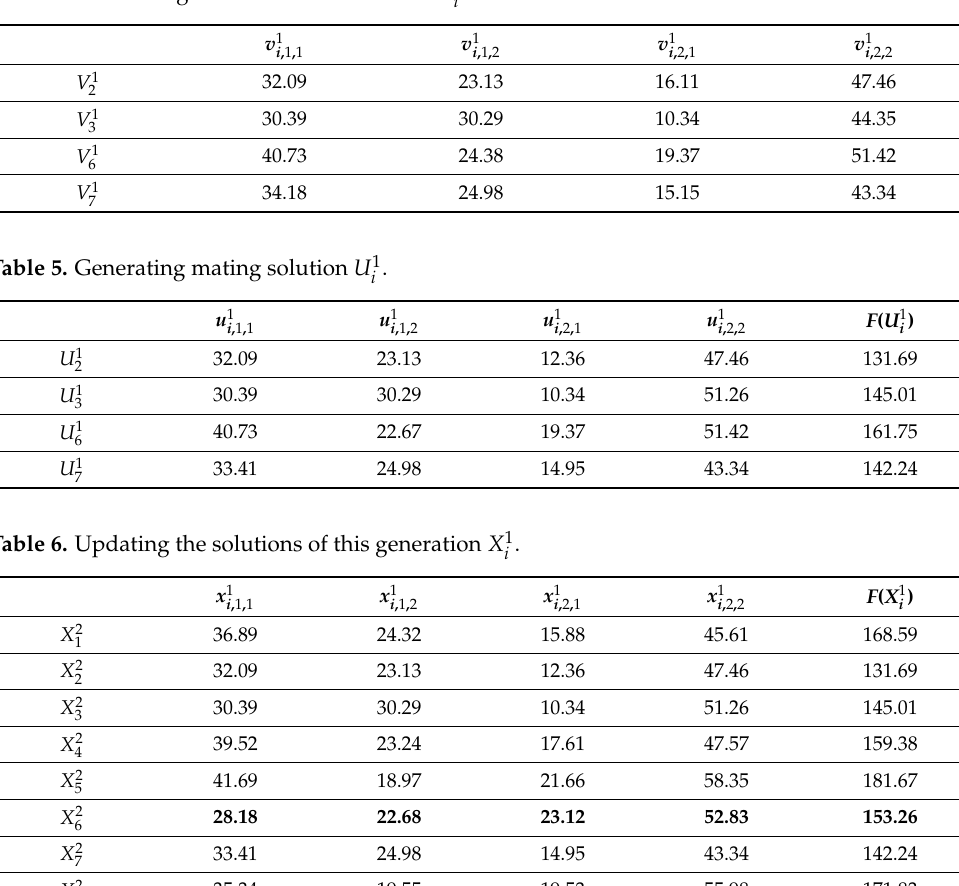
Table 4. Calculating the mutation solution of V 1